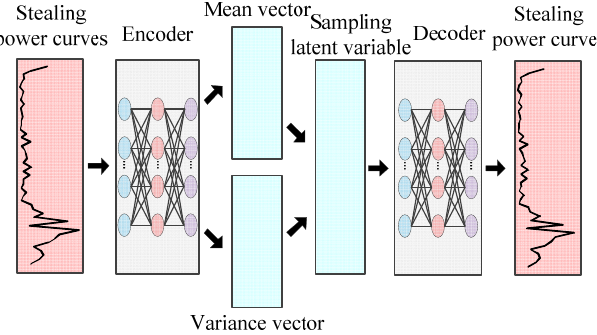
Figure 1. Process of generating stealing power curves by the conditional variational auto-encoder (CVAE). Step 1: The input data of CVAE are the stealing power curves and labels. Before inputting